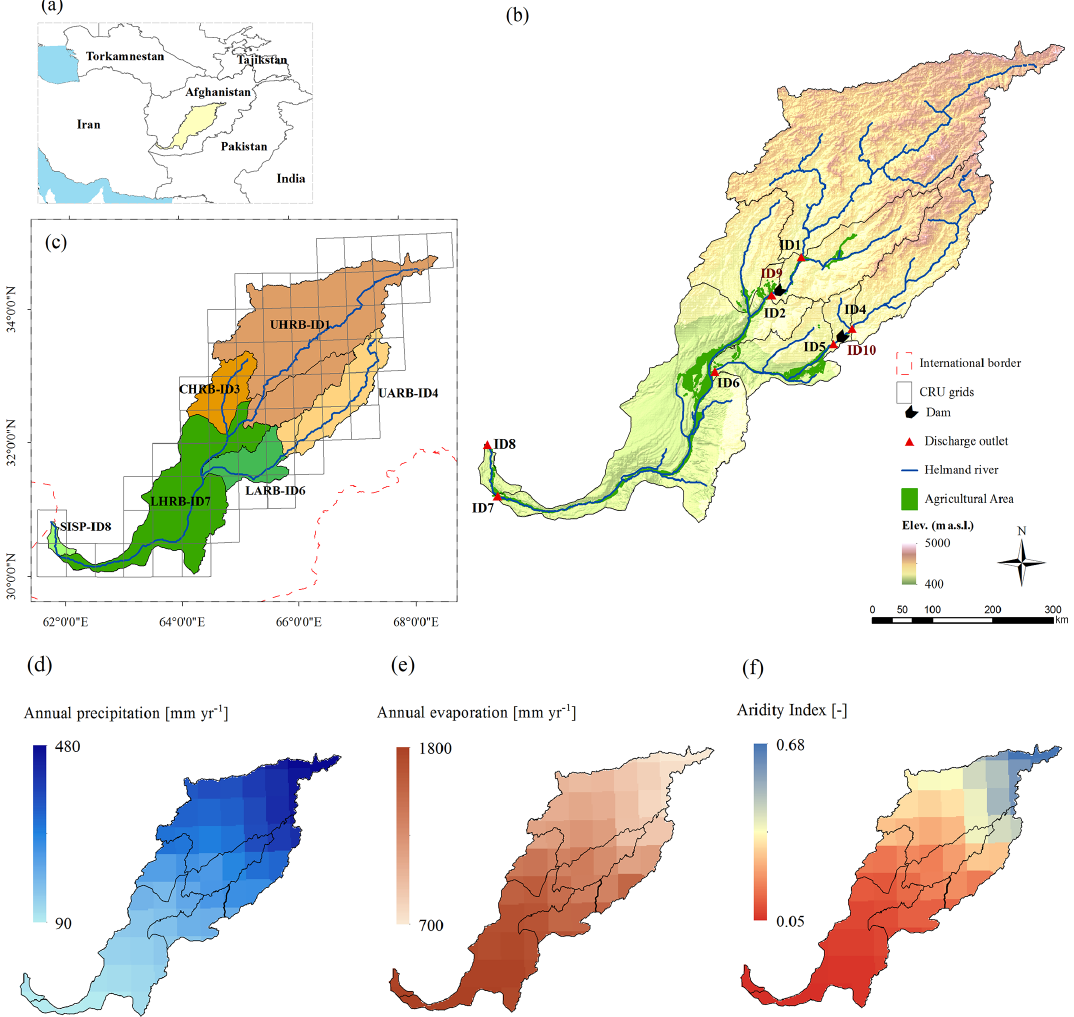
Figure 1. (a) The location of Helmand River basin (HRB) in central Afghanistan; (b) elevation map of the HRB, also indicating the sub-basin boundaries, the locations of the sub-basin outlets, and the agriculturally used area (as of 2006); (c) outline of the sub-basins analyzed in this study, including the grid cells of CRU precipitation data used; (d) long-term mean annual precipitation P [mmyr − 1 ]; (e) long-term mean annual potential evaporation E P [mmyr − 1 ]; and (f) the aridity index I A = P/E P